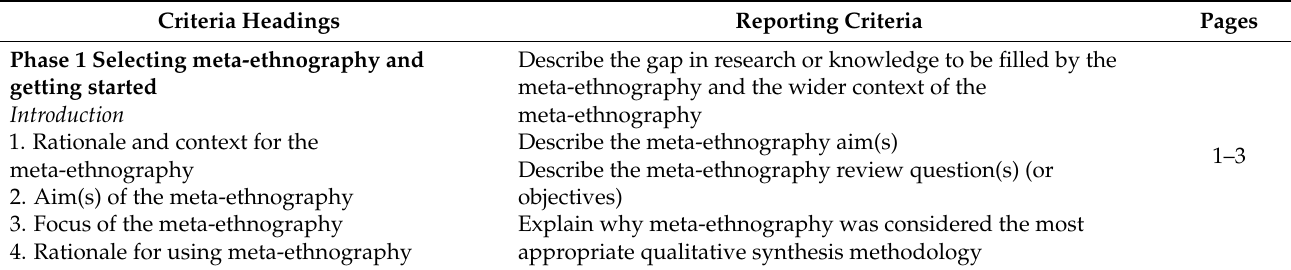
Table 1. The eMERGe meta-ethnography reporting guidance